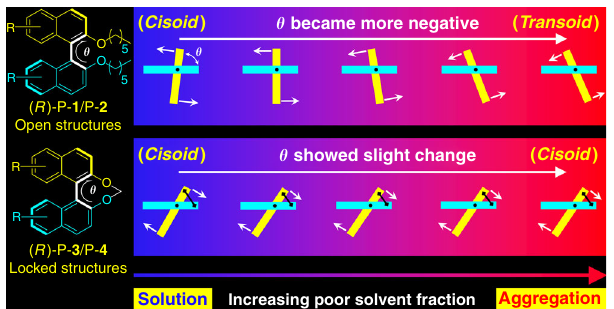
Fig. 6 Schematic representation of the conformational change of ( R ) − 1,1 ′ - binaphthyl moieties during the aggregation